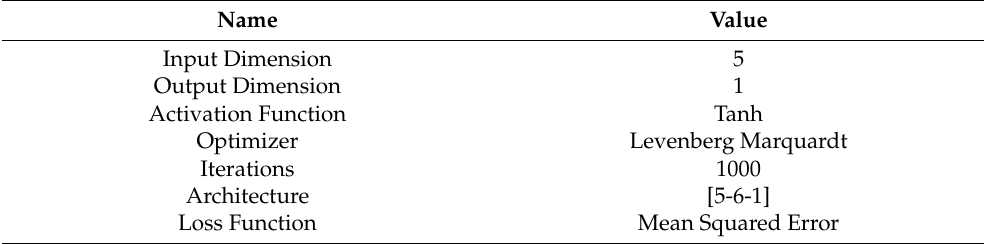
Table 2. Architecture of the network. Name